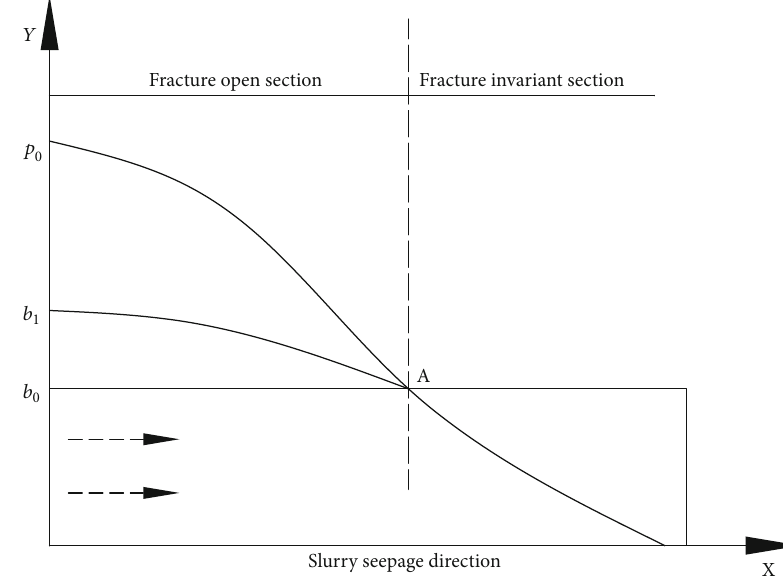
Figure 3: Curve of fracture opening and grouting